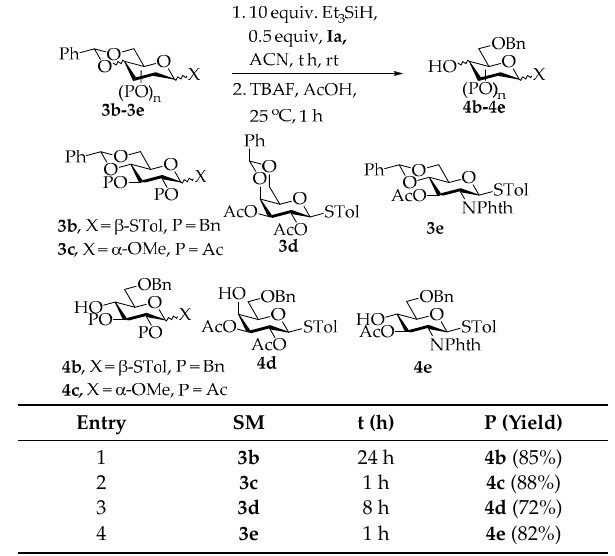
Table 4. Reductive ring-opening of various 4,6- O -benzylidene-D-hexopyranosides at room temperature in the presence of Ia as a catalyst.